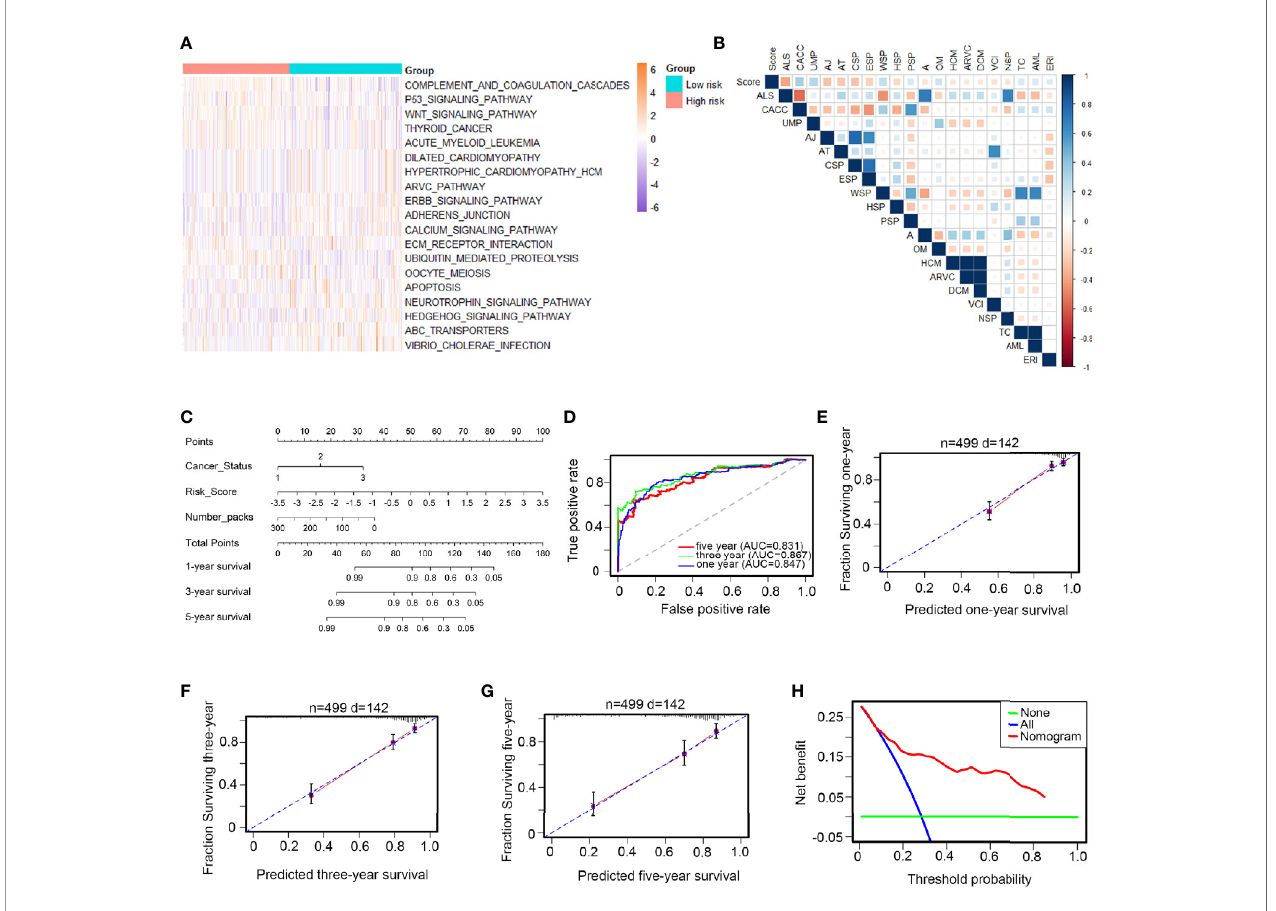
FIGURE 3 | Biological functions and clinical applications of the 12 TFs. (A, B) Pathway pro fi les in the light of TCGA dataset. Rows referred to pathways, and columns stood for patients. Each grid stood for a score of pathway activity calculated by single-sample GSEA. The ssGSEA score was further rescaled by min-max normalization method. The upper horizontal bar marked the information involved in every case which contained risk cluster and risk score (from low to high). In order to fi t the picture size, the pathway labels in (B) were handled as abbreviations of the corresponding pathway names in (A) . (C) The nomogram was performed in the entire TCGA database, with cancer status as well as number packs. (D) 1-, 3-, 5-year ROC curves for the TFs-based nomogram. (E – G) Represented the 1-, 3-, 5- year nomogram calibration curves, respectively. The closer the dotted line fi t to the perfect line, the better the predictive performance of the nomogram was. (H) The decision curve analysis (DCA) for the nomogram. The net bene fi t was plotted versus the threshold probability. The red line was the nomogram. The blue line was the treat-all and the green was the